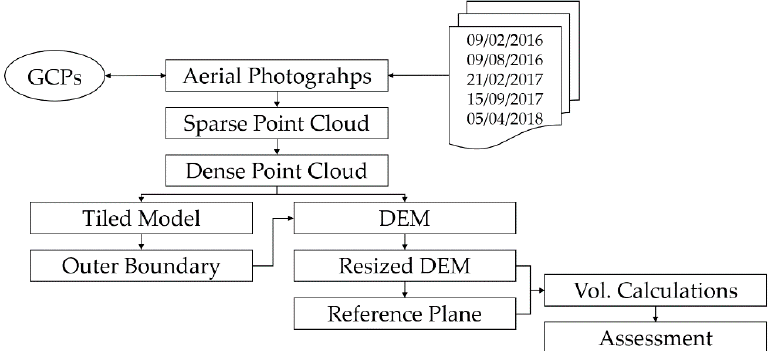
Figure 2. Applied methodology involving integration of ground control points (GCPs) with photographs and production of digital elevation model (DEM)